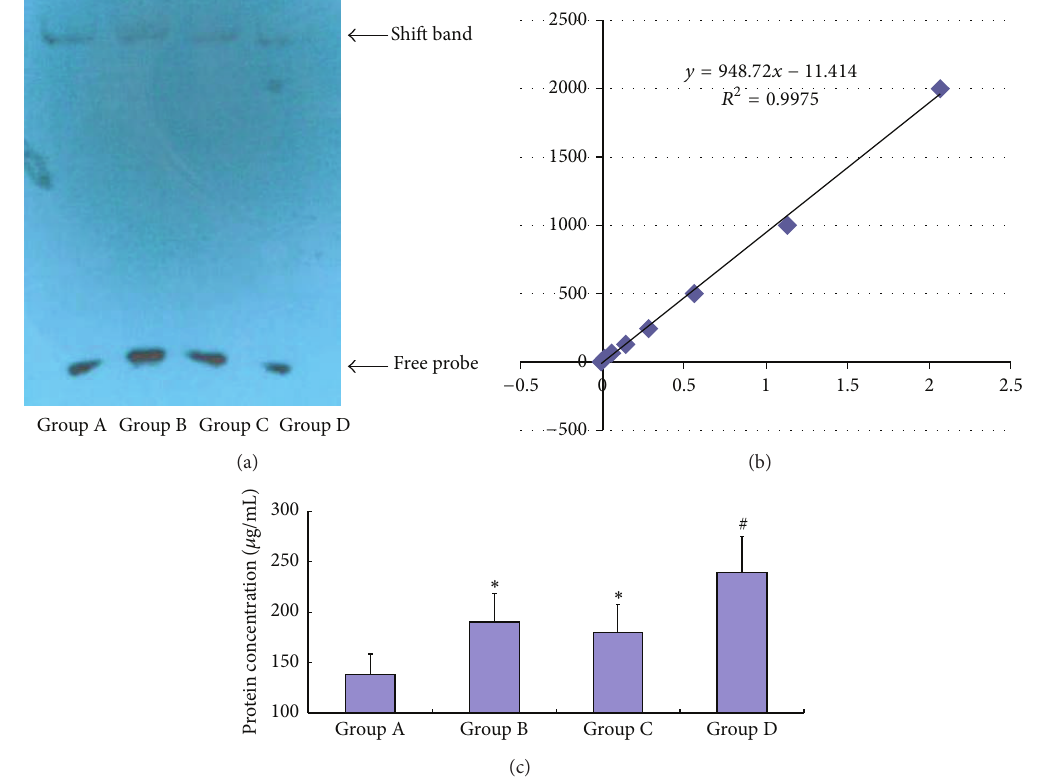
Figure 1: The examination of NF 𝜅 B activation in macrophages. (a) Scanned EMSA gel images. (b) Standard curves. (c) Statistical graph of the EMSA results. ∗ indicates statistically significant differences compared with Group A ( 𝑃 ≤ 0.05 ). # indicates statistically significant differences compared with groups B and C ( 𝑃 ≤ 0.05